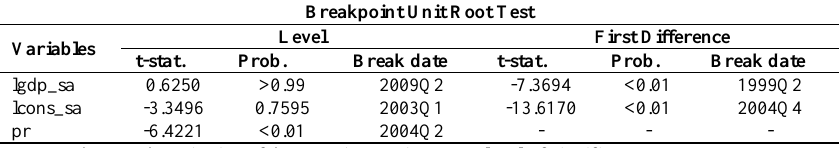
Table 1. Breakpoint Unit Root Test